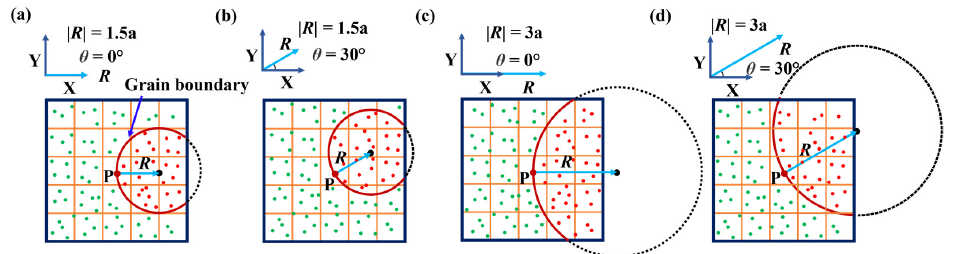
Figure 2. The relative position of the GB and the curvature calculation region. ( a ) θ = 0°, | R | = 1.5a, ( b ) θ = 30°, | R | = 1.5a, ( c ) θ = 0°, | R | = 3a, and ( d ) θ = 30°, | R | = 3a.